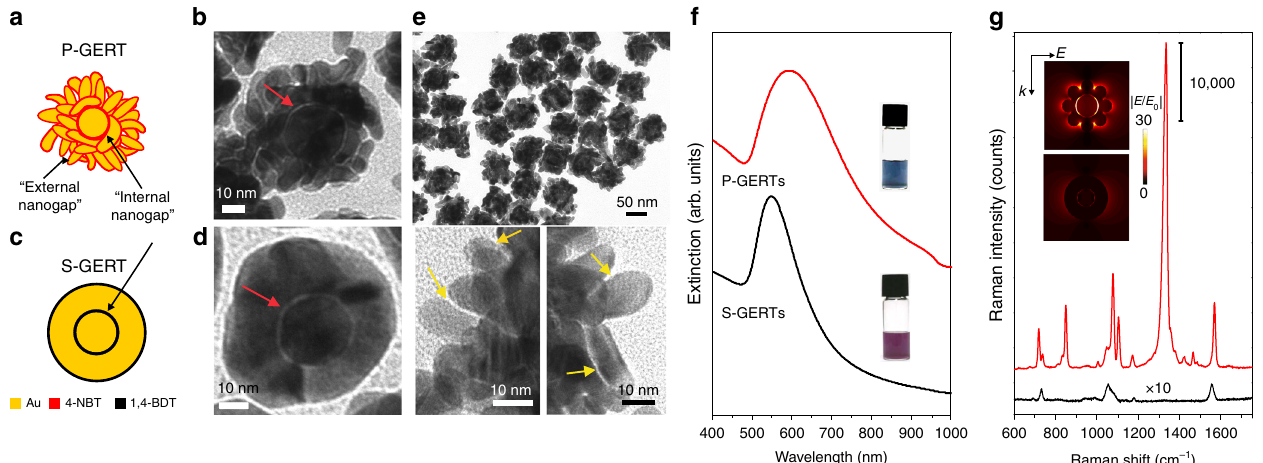
Fig. 1 The comparison of P-GERTs and S-GERTs. Schematic diagrams and representative TEM images of GERTs with a petal-like shell (P-GERTs, a , b ), and GERTs with a smooth-surface shell (S-GERTs, c , d ). Red arrows in panel b , d indicate the internal nanogaps of GERTs. The scale bars are 10 nm. e Representative low-resolution TEM image (top, the scale bar is 50 nm) and high-resolution TEM images (bottom, the scale bar is 10 nm) of P-GERTs. Yellow arrows in panel e indicate the external nanogaps between petal-like structures on the shell of P-GERTs. f Extinction spectra of P-GERTs (red) and S- GERTs (black). The insets in panel f show the corresponding photos of GERTs solution. g SERS spectra of P-GERTs (red) and S-GERTs (black). The insets in panel g show the fi nite-difference time-domain (FDTD) calculated electric fi eld enhancement distribution of a single P-GERT (top) and S-GERT (bottom) excited by 638 nm. Raman measurements were performed using 638 nm laser, 2 s acquisition time, and ×10 objective